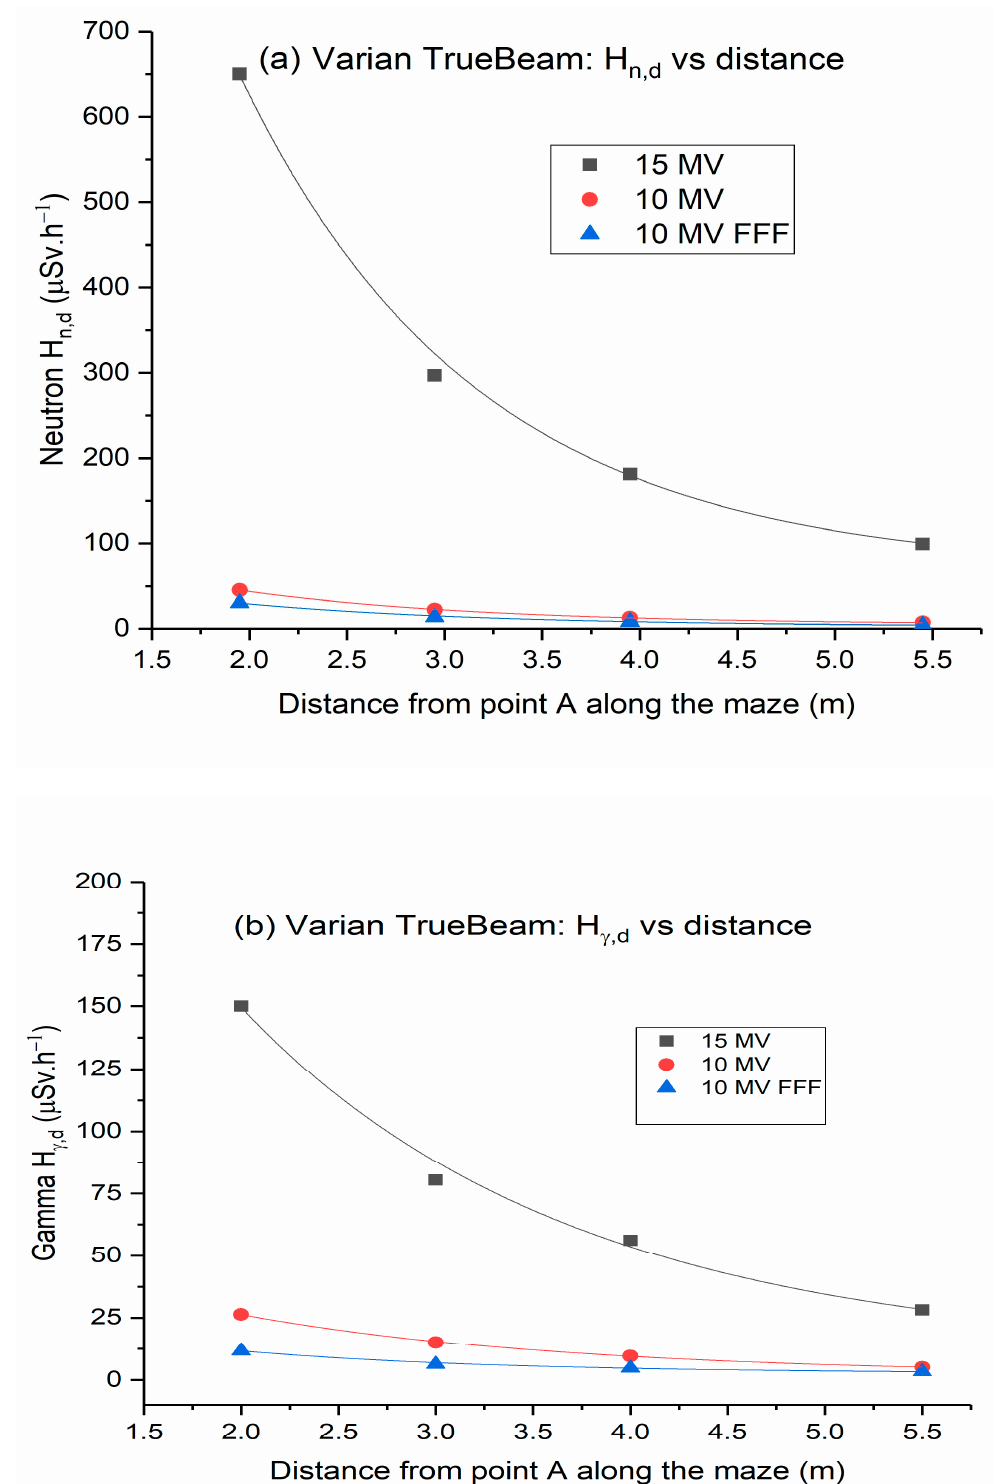
Figure 2. Dose equivalent rates along the maze of Varian TrueBeam linear accelerator: ( a ) neutron dose rates; ( b ) gamma dose rates. (Error bars are not shown because they are too small to be visible in the graph).